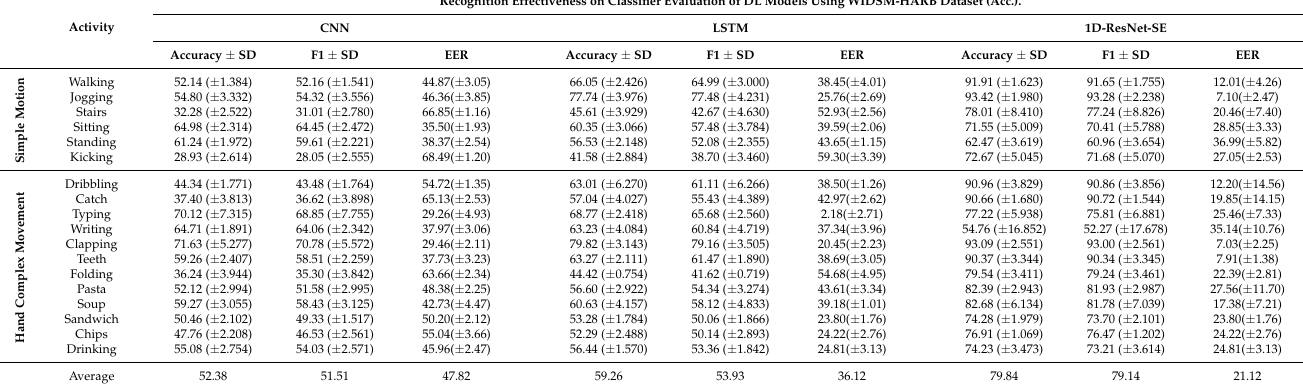
Table 6. Recognition effectiveness on classifier evaluation of deep learning models using WIDSM- HARB dataset (Acc.